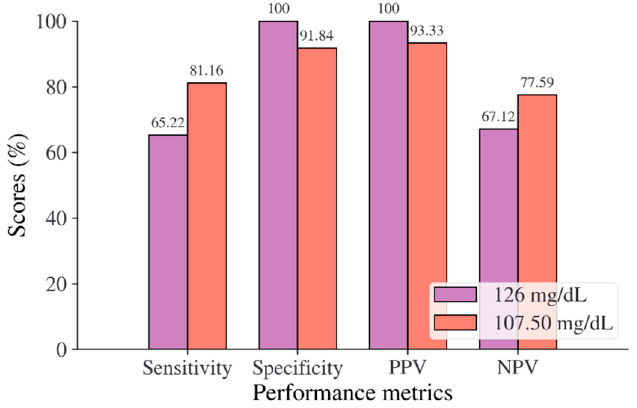
Figure 7. Sensitivity, specificity, PPV, and NPV for 2hPG in the US-PIMA Indian adult population based on ADA and WHO cut point recommendations compared to the optimal cut point.